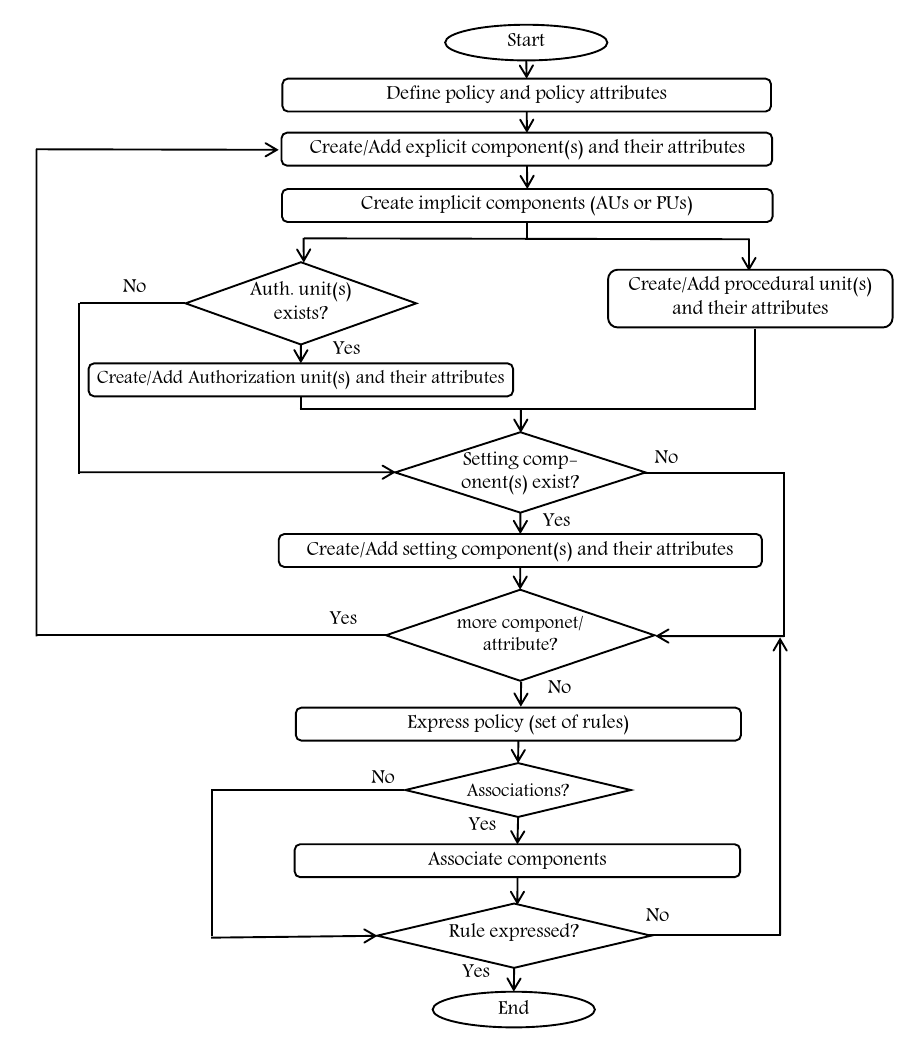
Figure 19. Instantiation of AC models using the DSL of HEAD